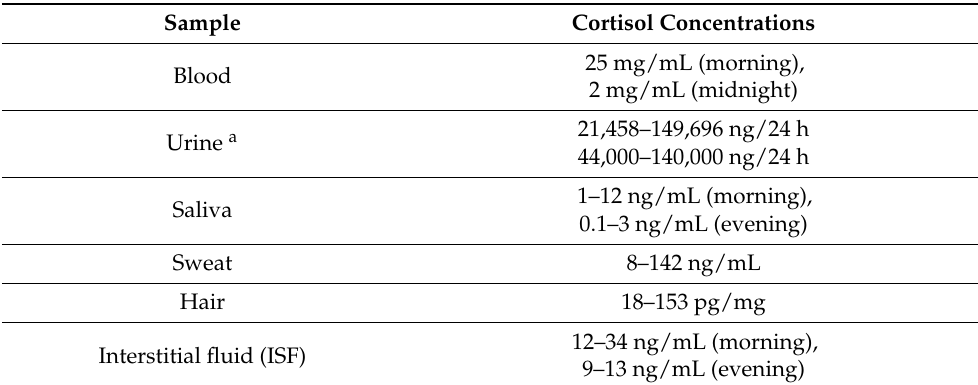
Table 1. Cortisol levels in different biological samples in nominally healthy subjects. Adapted with permission from [17]. Copyright 2020 Elsevier.